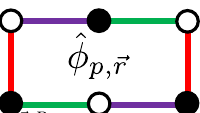
⃗ n + l ⃗ n ∈ (cid:78) ( l , l + ) and the 1 1 2 2 1 2 and ⃗ n are the primitive vectors. White and black 1 2 (d) The terms in Hamiltonian (2).